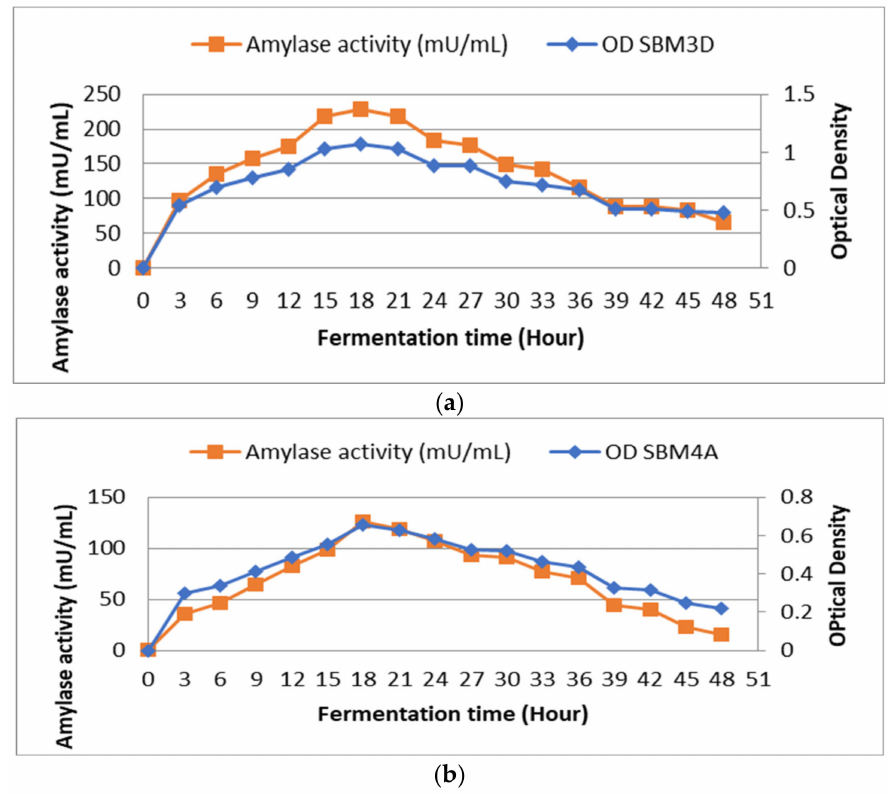
Figure 1. Effect of fermentation time on the growth and activity amylase enzyme of the BAL strains isolated from Wakawondu ( a ) SBM3D; and ( b )